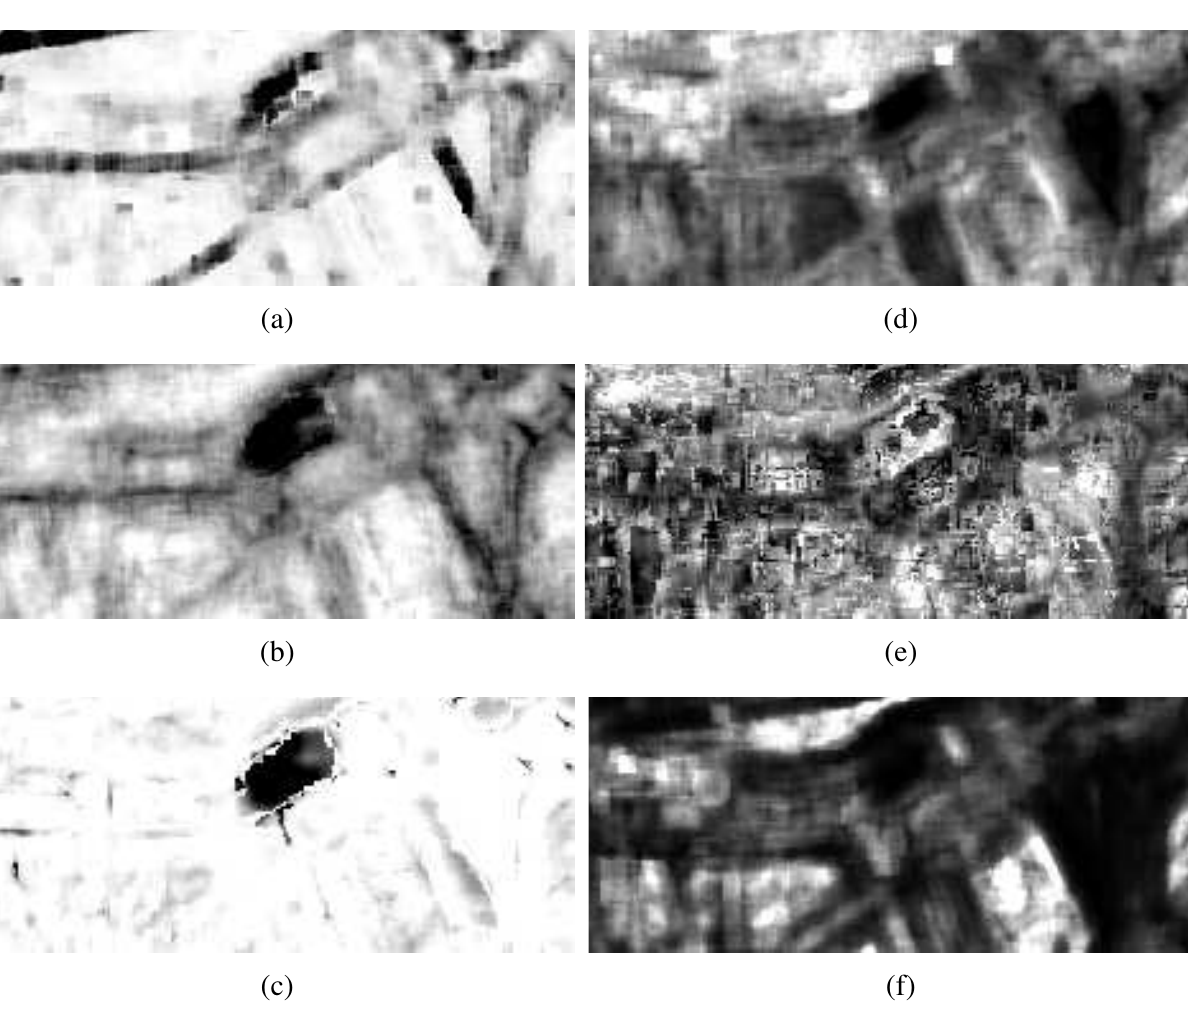
Figure 10. Similarity images of the panchromatic/HS pair: (a) distance to independence; (b) mutual information; (c) CRA; (d) Woods criterion; (e) robust Woods criterion; (f) correlation